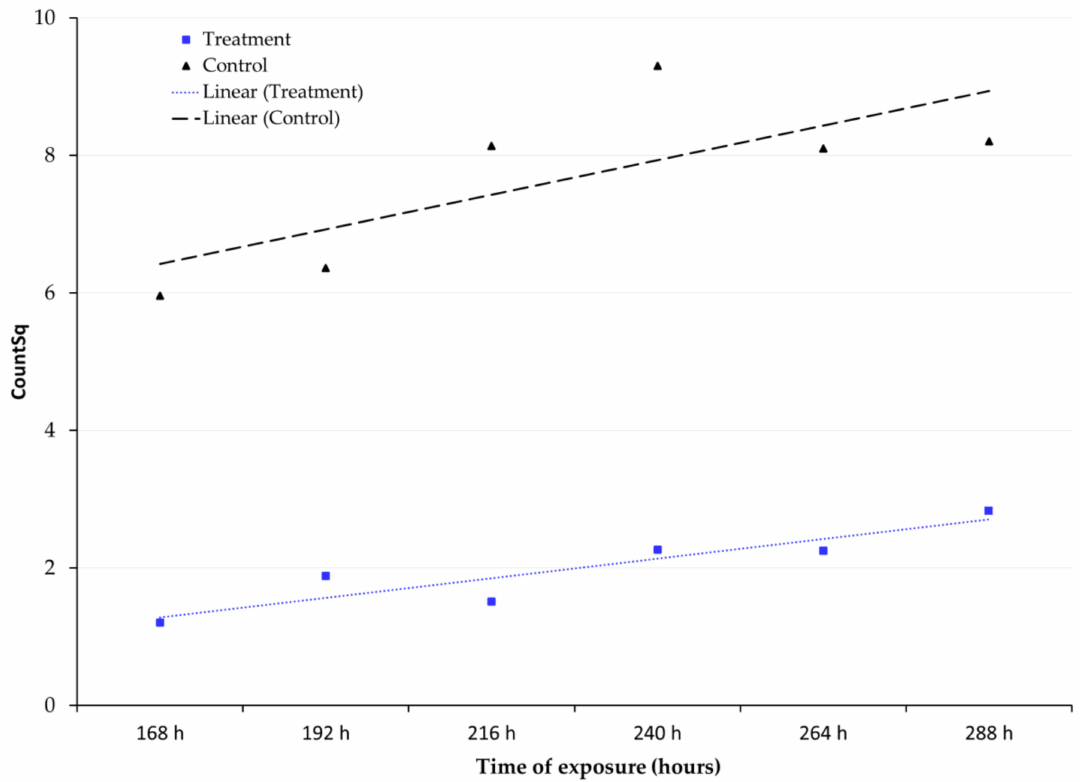
Figure 2. Insect emergence from the treated grain after exposure to 5% oxygen at 25 ± 1 ◦ C and 40 ± 5% RH for forty-five days. “Countsq” refers to the square rooted value of adult insects that emerged after exposure to normoxic conditions following hypoxia